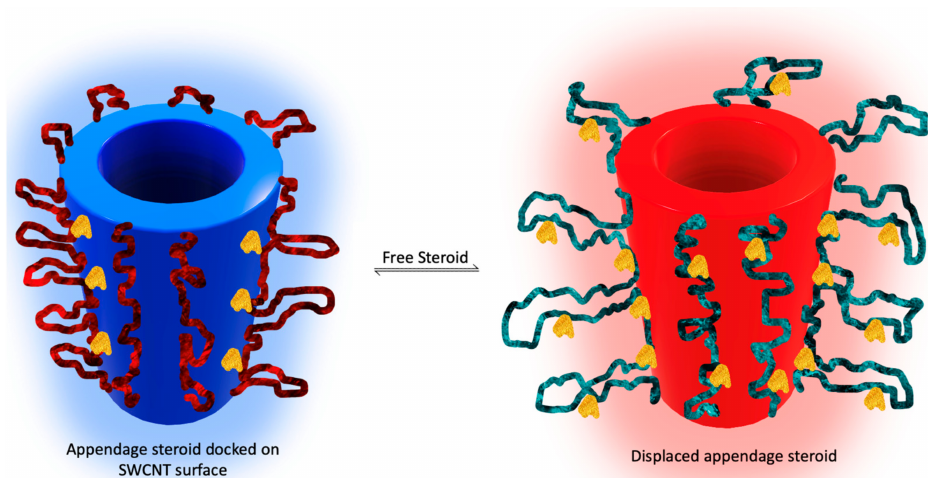
Figure 9. Simplified scheme for the illustration of the equilibrium reaction—displacement of the interpolymer-bound cortisol hapten (acrylated cortisol) by free cortisol molecules. Competing for docking closely at the SWCNT surface interpolymer pockets, free cortisol and hapten reconfiguring polymer loops change the nano-environment of the SWNT, producing the analytical signal based on the SWNT corona phase recognition measurement to monitor the free cortisol fluctuations over time in hydrogel, allowing for the free diffusion of steroids from the liquid samples in contact with them (Reproduced with permission from Wiley